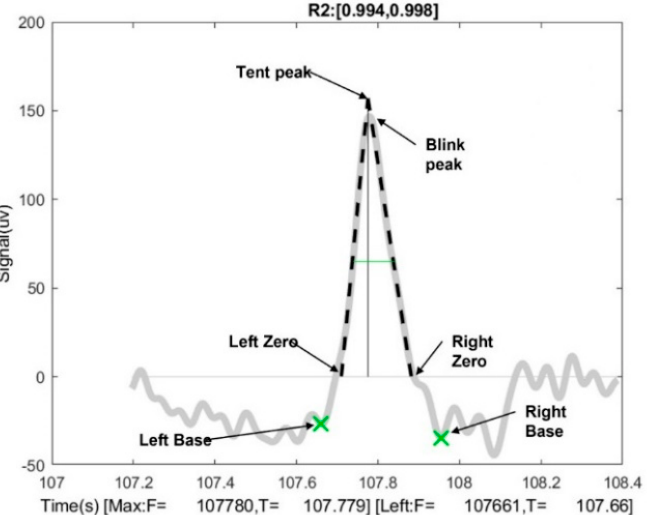
Figure 2. A schematic diagram of an eye-blink signal with the various blink landmarks used by the BLINKER software [27].